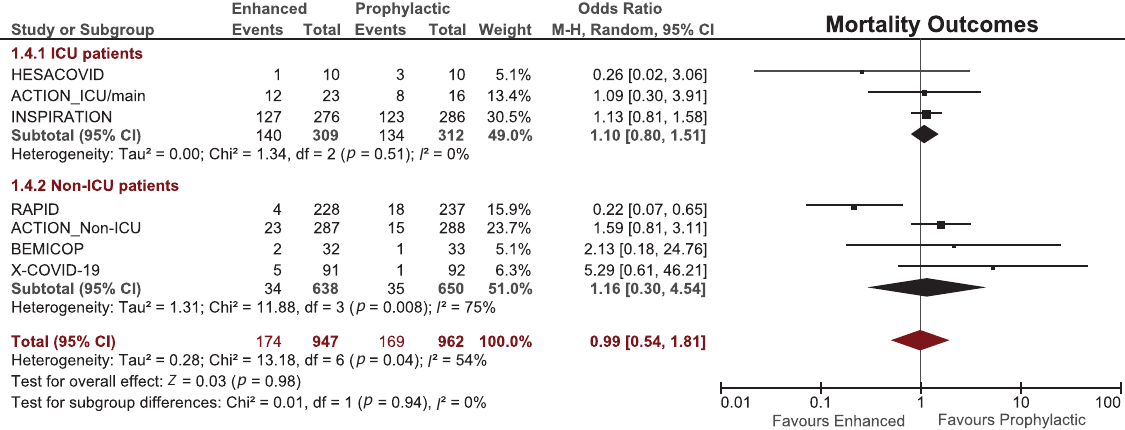
TH Open Vol. 6 No. 4/2022 © 2022. The